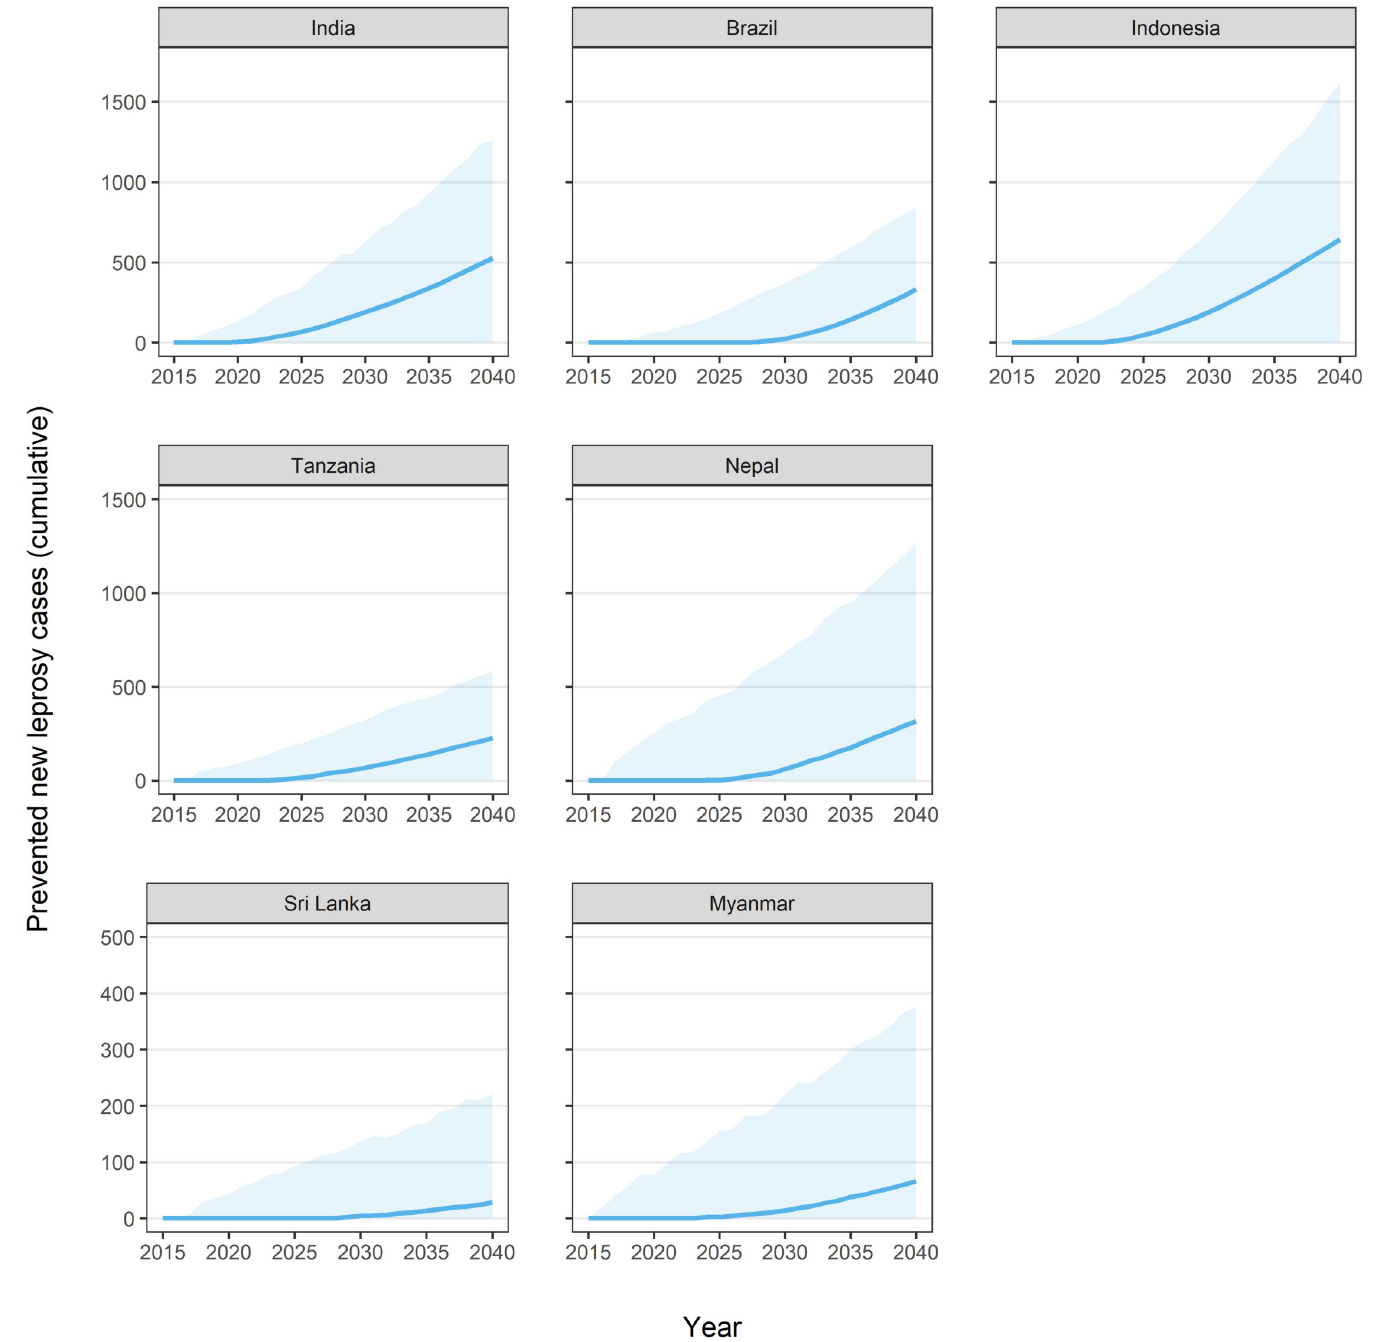
Fig 3. Number of cumulative new leprosy cases prevented due to the LPEP program activities as compared to the routine programme alone. Each panel represents the trends in subnational states or districts (arranged in descending order of baseline endemicity level): India (Union Territory Dadra and Nagar Haveli); Brazil (Alta Floresta city and region and Rondono´polis city in Mato Grosso, Araguaı´na and Colinas do Tocantins in Tocantins, Petrolina city and region in Pernambuco); Indonesia (Sumenep district); Tanzania (Kilombero, Liwale and Nanyumbu); Nepal (Jhapa, Morang and Parsa districts); Sri Lanka (Kalutara and Puttalam districts); Myanmar (Nyaung Oo, Myingyan and Tharyarwaddy Townships). Model predictions are represented by means of 1,000 repeats (solid line). The blue line represents the LPEP program. The shaded area is the 95% prediction interval.